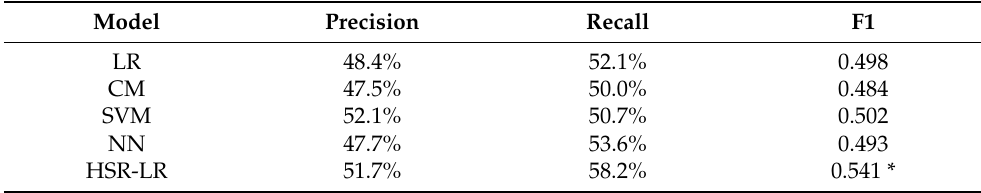
Table 8. Results on MC2.